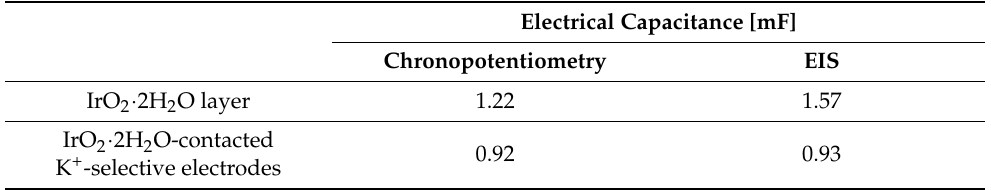
Table 1. Electrical capacitance parameter obtained for IrO 2 · 2H 2 O solid-contact layer and IrO 2 · 2H 2 O- contacted electrode using two electrochemical